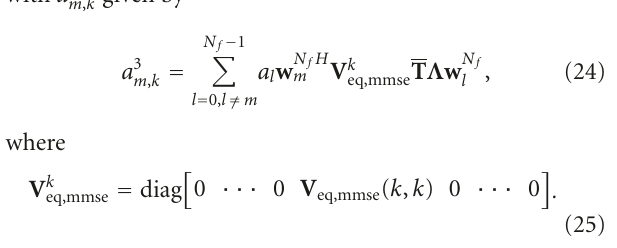
Figure 4: BER performance of MC-CDMA with MMSE and ZF equalizers, evaluated from (21), for three di ff erent channel realizations (RFO = 0.05, N f = 64, and CR-1, CR-2, CR-3 refer to the channel realizations given in Table 1, and symbols are from 4-QAM constellation with P = 1).